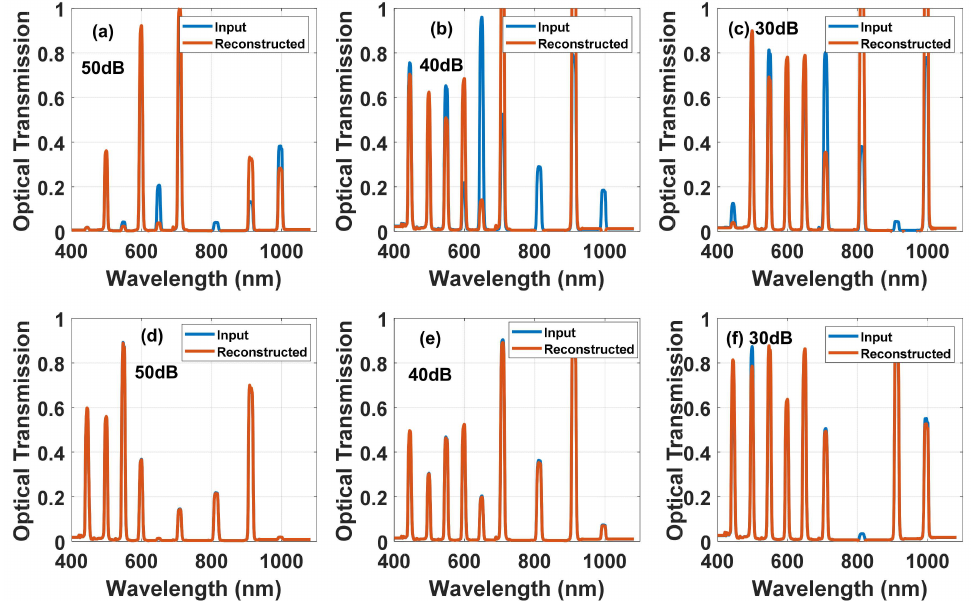
Figure 13. Simulated reconstructed spectra with the input signal is the blue curve and the red is the reconstructed ones using two different NLC E7 gaps, 6 µ m for ( a – c ) while 12 µ m for ( d – f ) and different SNR values in dB: ( a , d ) 50; ( b , e ) 40; ( c , f ) 30. The number of voltages is